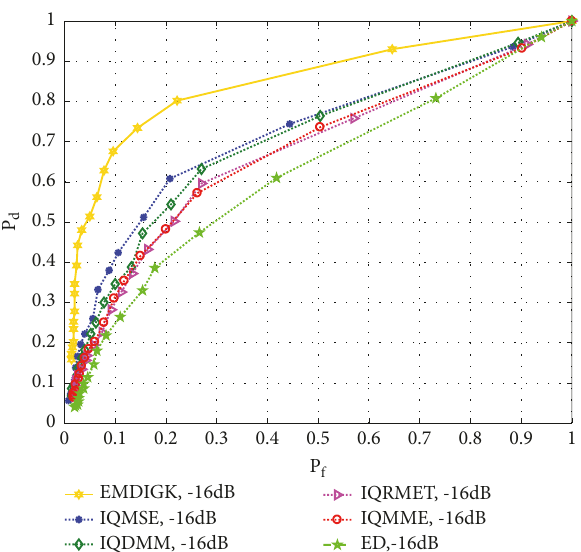
Figure 7: The ROC curve with GFV under 𝑆𝑁𝑅 = −16